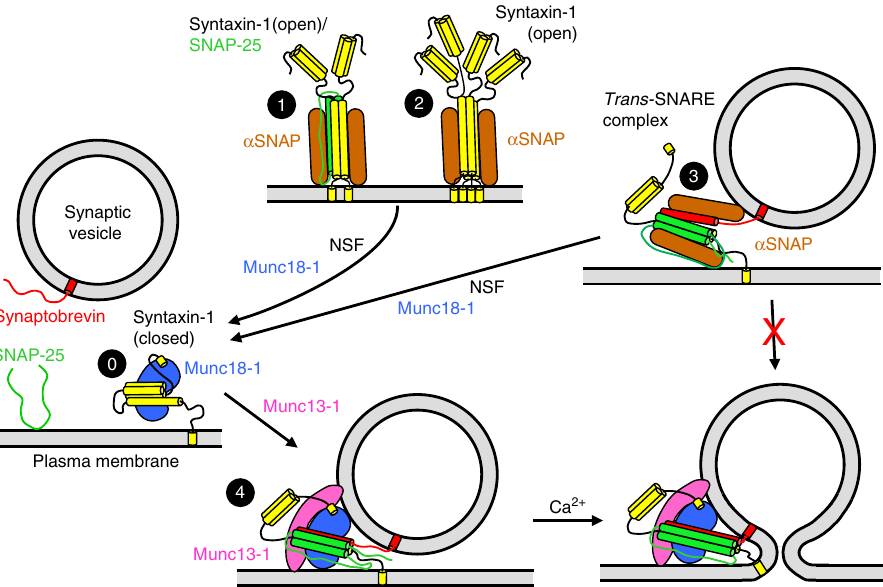
Fig. 1 Model of how α SNAP inhibition ensures that synaptic vesicle fusion requires Munc18-1 and Munc13-1. The model postulates that syntaxin-1 can exist in different states on the pre-synaptic plasma membrane, including a state where syntaxin-1 forms a closed conformation that binds to Munc18-1 (state 0), various states where syntaxin-1 forms heterodimers with SNAP-25 (state 1, shown with a 2:1 stoichiometry) and a tetrameric state (state 2). Trans -SNARE complexes can be potentially formed by the SNAREs alone (state 3), or through the Munc18-1-Munc13-1-dependent pathway that starts at state 0, leading to state 4. α SNAP can inhibit synaptic vesicle fusion by binding to the syntaxin-1 tetramers, hindering Munc18-1 binding, by binding to syntaxin-1-SNAP-25 heterodimers, precluding SNARE complex assembly, and by binding to trans -SNARE complexes formed by SNAREs alone, preventing membrane fusion. The mechanism underlying the latter inhibition is unclear, but we speculate that binding of distinct α SNAP molecules to the SNAREs and to the apposed membranes hinders C-terminal SNARE complex zippering. In states 1 – 3, only two α SNAP molecules are shown for simplicity, but up to four molecules are expected to be able to bind to each SNARE four-helix bundle 53 . α SNAP cannot inhibit fusion through the pathway that starts with Munc18-1 bound to closed syntaxin-1 because this interaction impedes α SNAP binding and access of α SNAP to trans -SNARE complexes is obstructed by Munc18-1 and/or Munc13-1. Synaptotagmin-1 and complexin, not shown for simplicity, may also contribute to prevent α SNAP binding to trans -SNARE complexes. This obstruction also prevents disassembly of the trans -SNARE complexes by NSF- α SNAP 36 (see